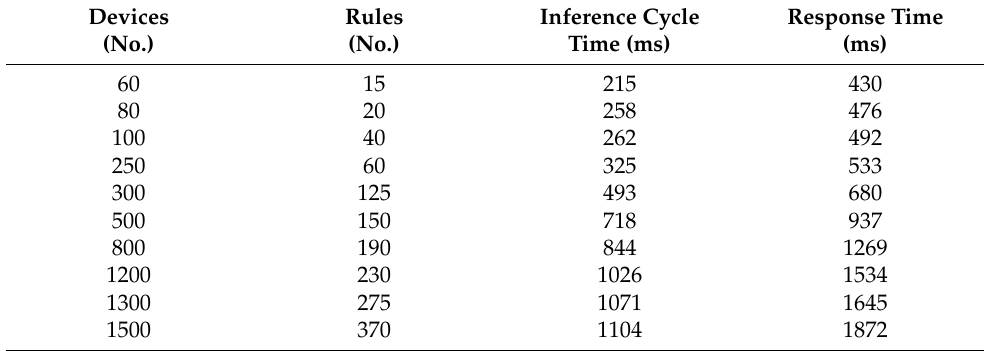
Table 6. Performance evaluation results.